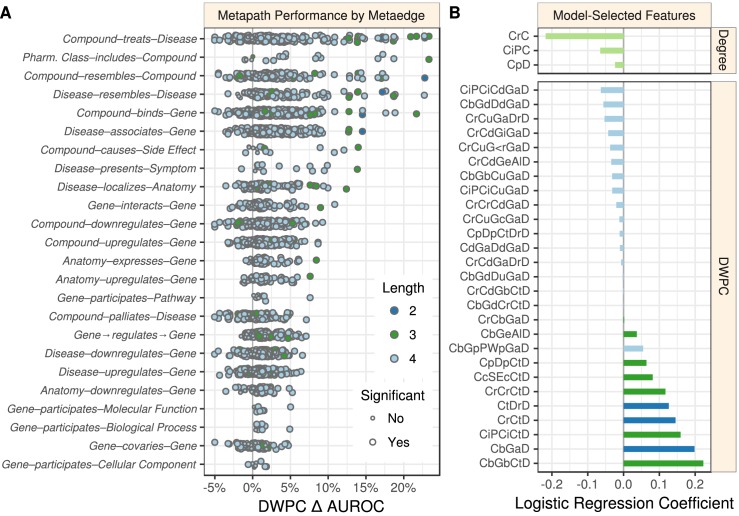
Performance by type and model coefficients.(A) The performance of the DWPCs for 1206 metapaths, organized by their composing metaedges. The larger dots represent metapaths that were significantly affected by permutation (false discovery rate < 5%). Metaedges are ordered by their best performing metapath. Since a metapath’s performance is limited by its least informative metaedge, the best performing metapath for a metaedge provides a lower bound on the pharmacologic utility of a given domain of information. (B) Barplot of the model coefficients. Features were standardized prior to model fitting to make the coefficients comparable (Himmelstein and Lizee, 2016a).